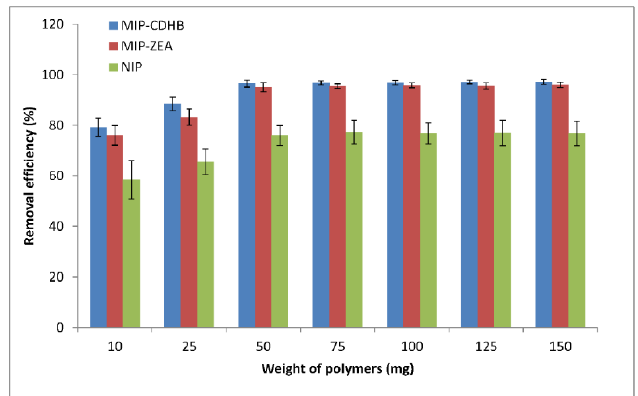
Figure 8. The percentage of ZEA removal at different amounts of adsorbents (MIP-CDHB, MIP-ZEA and NIP) for the following adsorption conditions: initial concentration = 1 mg·mL −1 ; solution volume = 25 mL; T = 298 K.